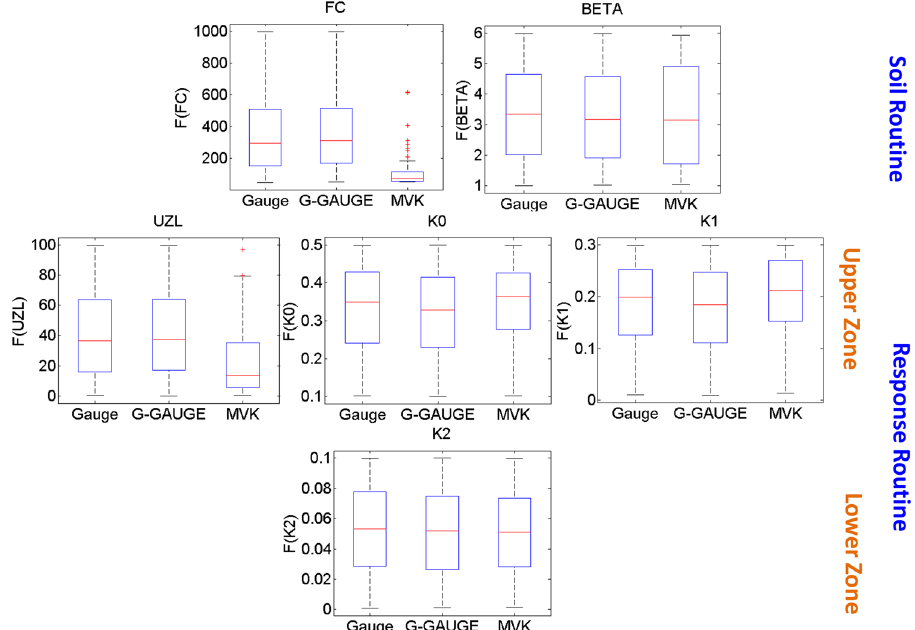
Fig. 7 Box plots of 6 param-